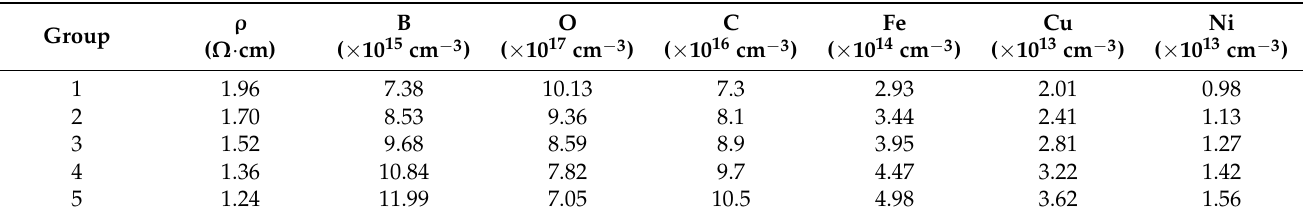
Table 1. The average values of resistivities and impurity contents of five groups of Cz-Si